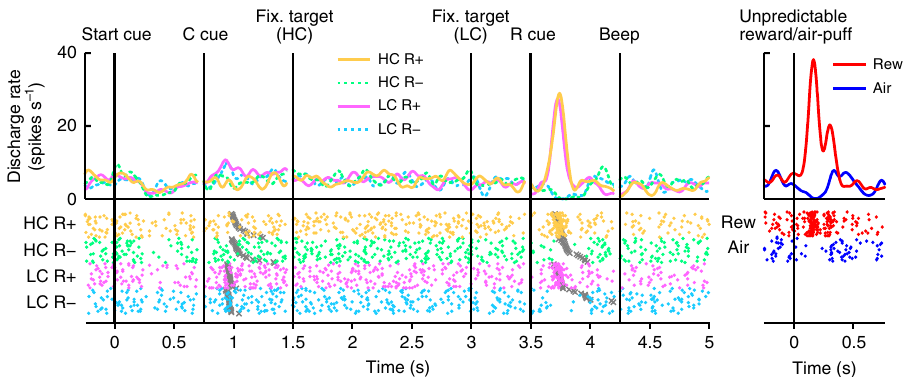
Fig. 2 Activity of a representative dopamine neuron in the HLC saccade task. Spike density functions (convolved with a Gaussian function) and raster plots are aligned with the onset timing of the start cue, the cost cue (C cue), the fi xation target, the reward cue (R cue), and the beep. Each color represents a condition (yellow: HC + , green: HC − , pink: LC + , cyan: LC − ), respectively. The timings of the saccade onset are indicated by gray crosses. The responses of the dopamine neurons to the unpredictable reward or air-puff are also represented in the right panel (red: unpredictable reward, blue: unpredictable